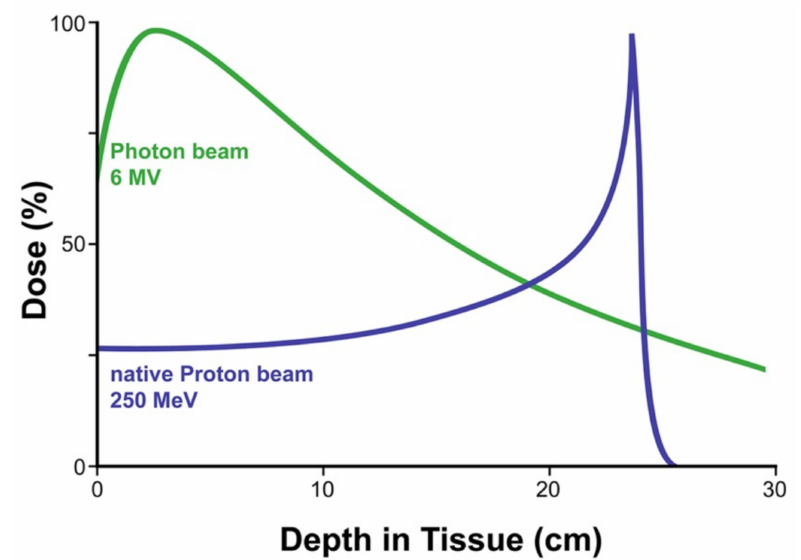
Figure 1. Graphical depiction of proton-beam dosage per tissue depth. The figure demonstrates that the dosage of the proton beam is higher in deeper tissues. The more superficial tissues are spared from increased dosages (blue line). In contrast, photon-beam radiation (green line) has increased dosage in superficial tissue with decreased dosage in deeper